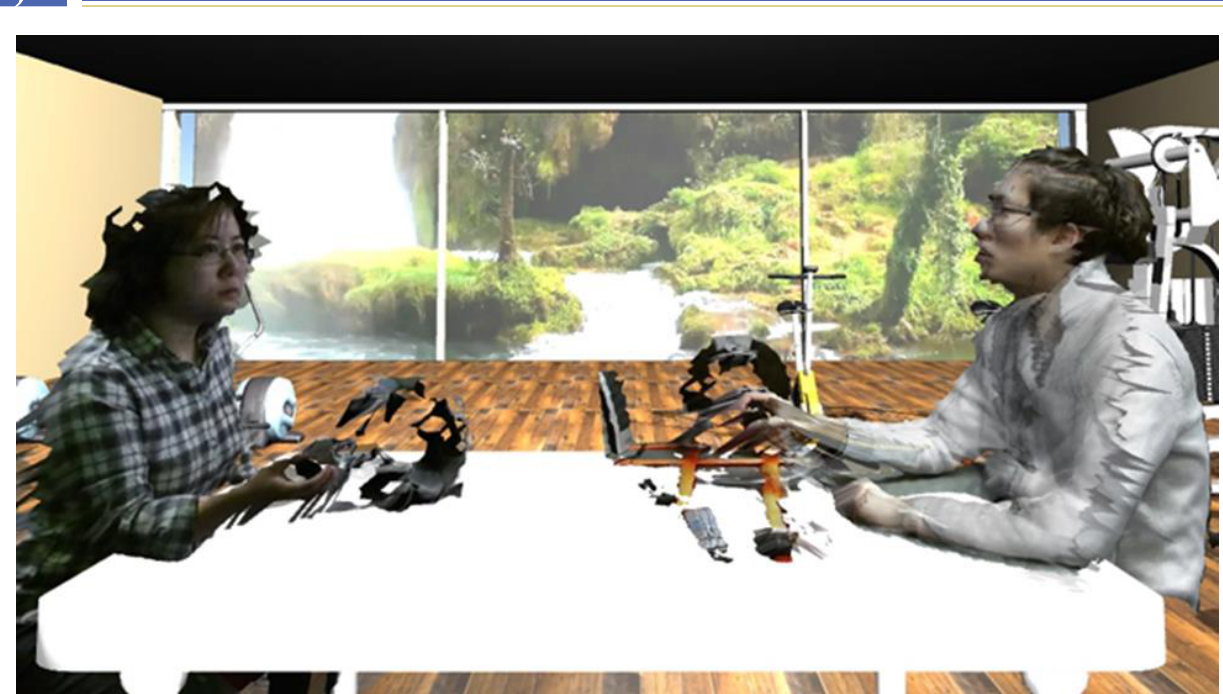
Figure 2 . 2D-Example of the 3D-video which the patient and evaluator see during the patient interaction. 3D-Glasses were necessary in order to perceive the three-dimensional video of the users/environment. (The artifacts seen around the edges were stitching artifacts generated when the two depth-sensing camera images were stitched